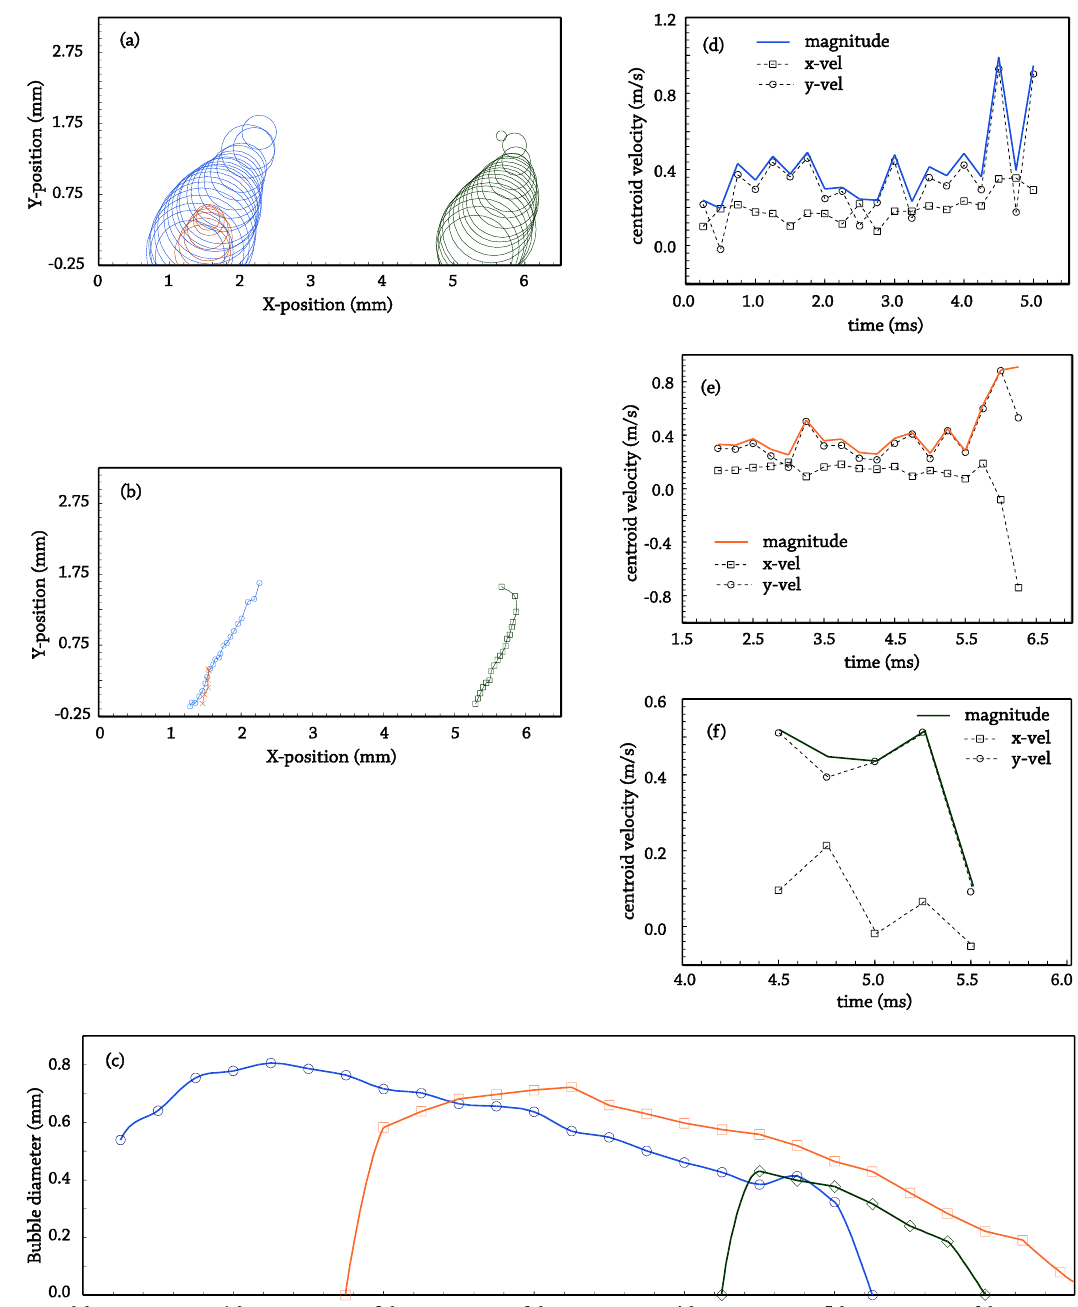
Figure 11. Side projection post-processing example for the frame sequence in Figure 10, T b = 95 °C, p = 150 kPa, G = 241 kg/s·m 2 , v = 0.25 m/s, q w = 300 kW/m 2 . ( a ) X-Y-size for detected bubbles; ( b ) bubbles’ centroid trajectories; ( c ) diameter-life diagram for recognized bubbles; ( d – f ) discrete calculation for the velocities of each of the recognized bubbles.